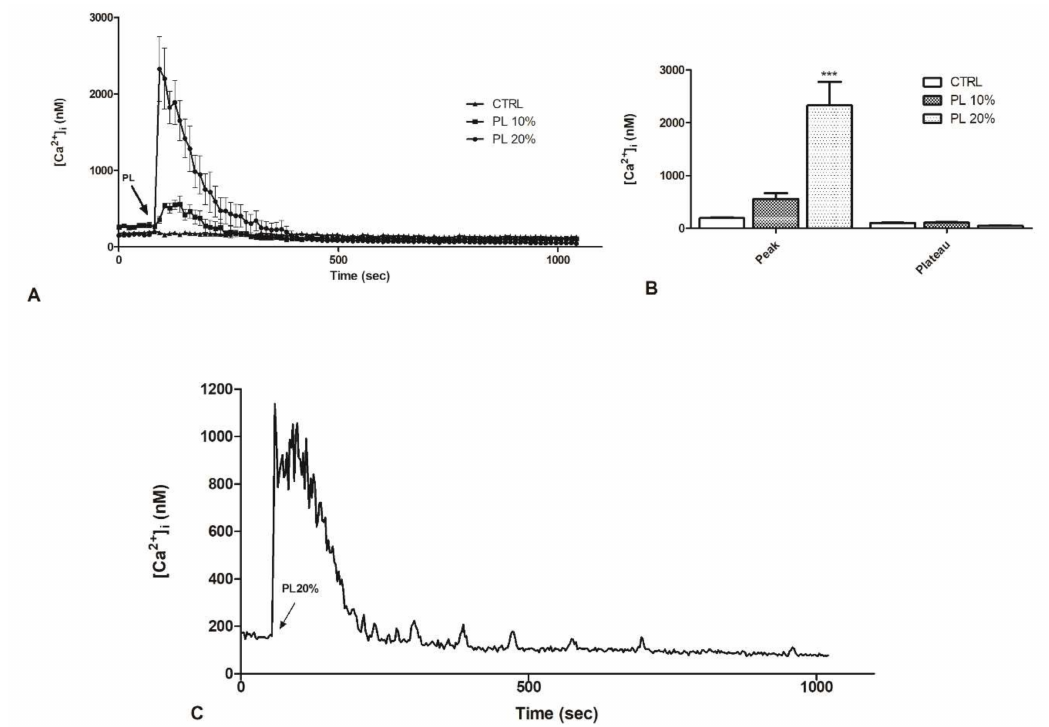
Figure 2. PL induces a dose-dependent increase in intracellular Ca 2 + concentration in bEND5 cells. ( A ) [Ca 2 + ] i variations recorded at 10 s intervals, showing no variations in control conditions (CTRL, i.e., cells incubated in confocal microscopy loading bu ff er, as described in Materials and Methods section), and distinct patterns of Ca 2 + signaling after exposure to 10% and 20% PL. Data are means ± s.e.m. of [Ca 2 + ] i traces recorded in di ff erent cells. Number of cells: CTRL: 20 cells from 2 experiments; 10% PL: 40 cells from 3 experiments; 20% PL: 40 cells from 3 experiments. ( B ) Mean ± s.e.m. of the peak Ca 2 + response induced by treatment with 10% or 20% PL. Number of cells: CTRL: 20 cells from 2 experiments; 10% PL: 40 cells from 3 experiments; 20% PL: 40 cells from 3 experiments. Asterisks on bars indicate statistical di ff erences determined by two-way ANOVA with Bonferroni’s correction ( p < 0.001). C . [Ca 2 + ] i variations recorded at 1 s intervals induced by 20% PL. Data are means ± s.e.m. of [Ca 2 + ] i traces recorded in 40 di ff erent